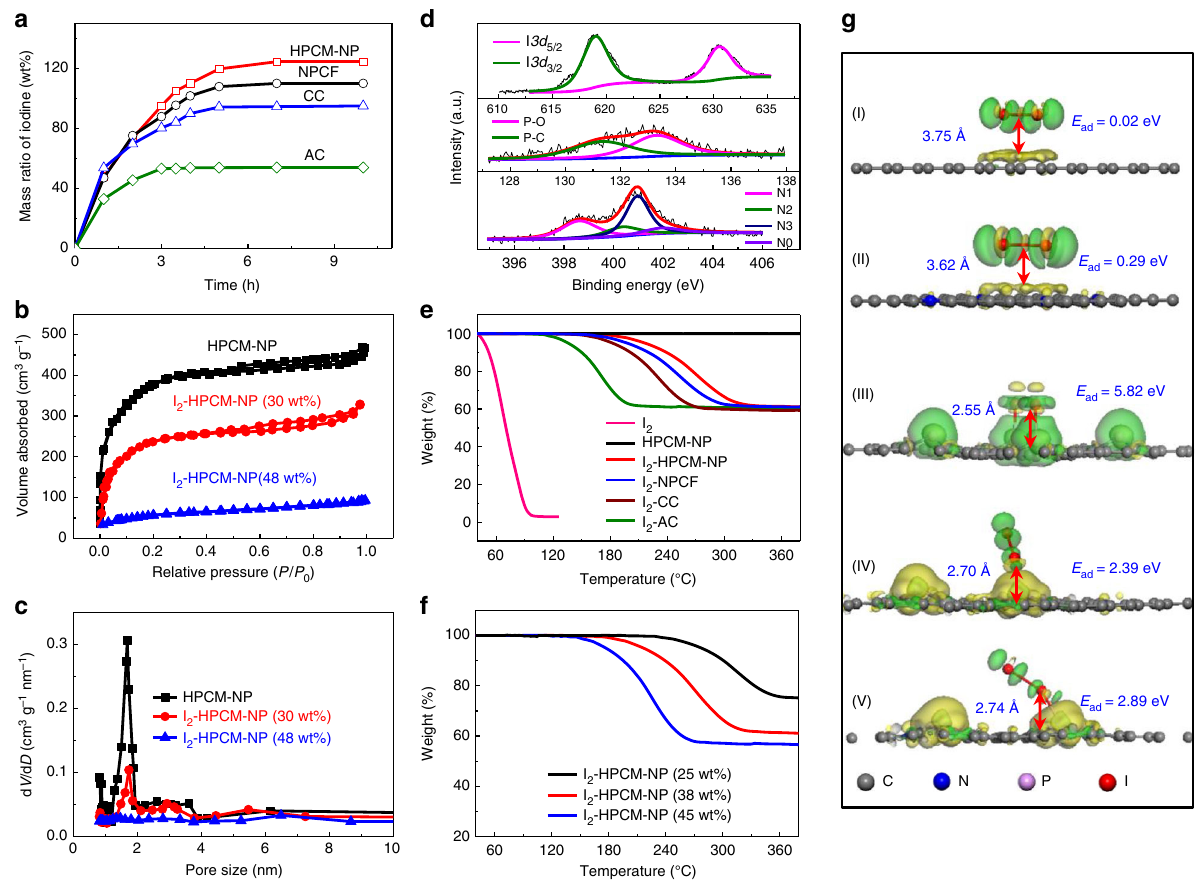
Fig. 2 Compositional characterization and stability analysis of iodine – carbon composites. a The time-dependent pro fi les for the mass ratio of iodine adsorbed on various carbons (the mass ratio is normalized to the mass of carbon). b N 2 adsorption-desorption isotherms and c the corresponding pore size distribution curves of HPMC-NP with different mass loading of iodine. d High-resolution XPS spectra of N1 s , P2 p , and I3 d for I 2 -HPCM-NP samples. Thermogravimetric analysis curves of e pure iodine and iodine-carbon composites (iodine content, 40 wt%), and f I 2 -HPCM-NP composite with different iodine content. g The contour plots of the difference in charge density for the optimized structures of iodine molecule adsorbed on graphene I, graphene doped with N (II), P (III), isolated N and P (IV), and coupled N and P (V). The differential charge density was calculated from: Δ ρ = ρ 12 − ρ 1 − ρ 2 , where ρ 1 , ρ 12 and ρ 2 are the chare density of iodine, doped graphene with and without iodine adsorbed on the surface, respectively. Yellow and green color indicate the charge depletion and accumulation, respectively. The adsorption energies for I 2 molecule on these fragments were obtained using: E ad = − ( E 1 + E 2 − E 12 ), where E ad is the adsorption energy of the I 2 molecule on the corresponding surfaces, E 1 is the total energy of the graphene (or heteroatom doped graphene), E 2 is the energy of one isolated I 2 molecule, and E 12 is the energy of the optimized structures for I 2 molecules adsorbed on the graphene planes. The bond lengths and heights of adsorbed I 2 molecule are also listed in the fi gure, along with the corresponding adsorption − 1 of HPCM-NP decreased from 1487 to 85 m 2 g (Fig. 2b) with an